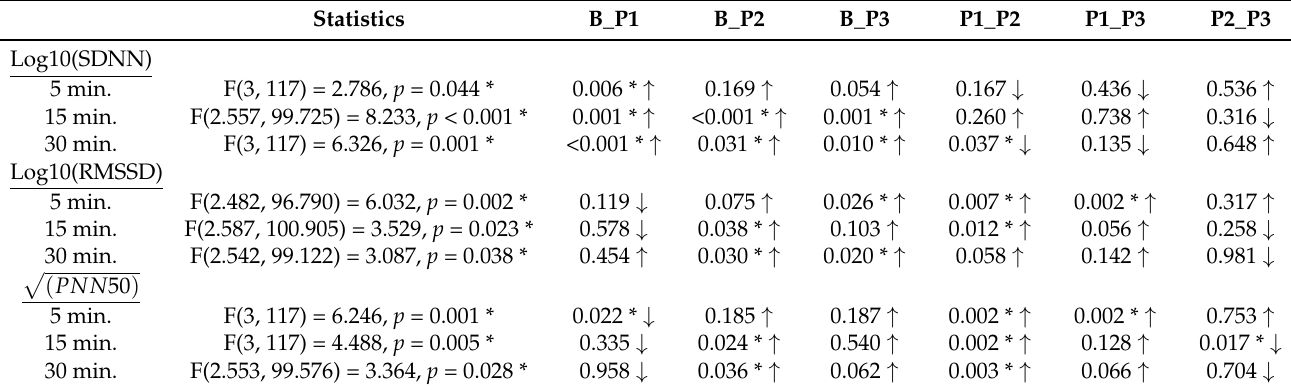
Table 3. The effect of deep breathing on HRV in healthy participants reported with a one-way repeated measures ANOVA and p -values of the post hoc test. A significant effect of time was seen for all three doses (5, 15, and 30 min). SDNN, RMSSD, and PNN50 increased from baseline to some post measurements with a dose of 5 or 15 min while 30 min of deep breathing increased SDNN, RMSSD, and PNN50 from baseline to most post measurements. HRV: Heart rate variability. ANOVA: Analysis of Variance. * Shows statistical significance. ↑ Shows an increase with respect to the baseline. ↓ Shows a decrease with respect to the baseline. The left column shows the name of the HRV-measure and each of the three interventional doses that were tested: 5, 15, and 30 min. Statistics: F(df (Time), df (Error (Time))) = F-value, p -value. SDNN: The standard deviation of the R-R intervals. RMSSD: The root mean square of successive R-R intervals. PNN50: The proportion of NN50 (pairs of successive R-R intervals that differ more than 50 milliseconds) divided by the total number of R-R intervals. Post1, post2, and post3 were performed at 0–5, 12.5–17.5, and 25–30 min after the deep breathing intervention, respectively. “B_PX” refers to the comparison between baseline and post1, post2, or post3. “PX_PX” refers to the comparison between post1, post2, or post3.